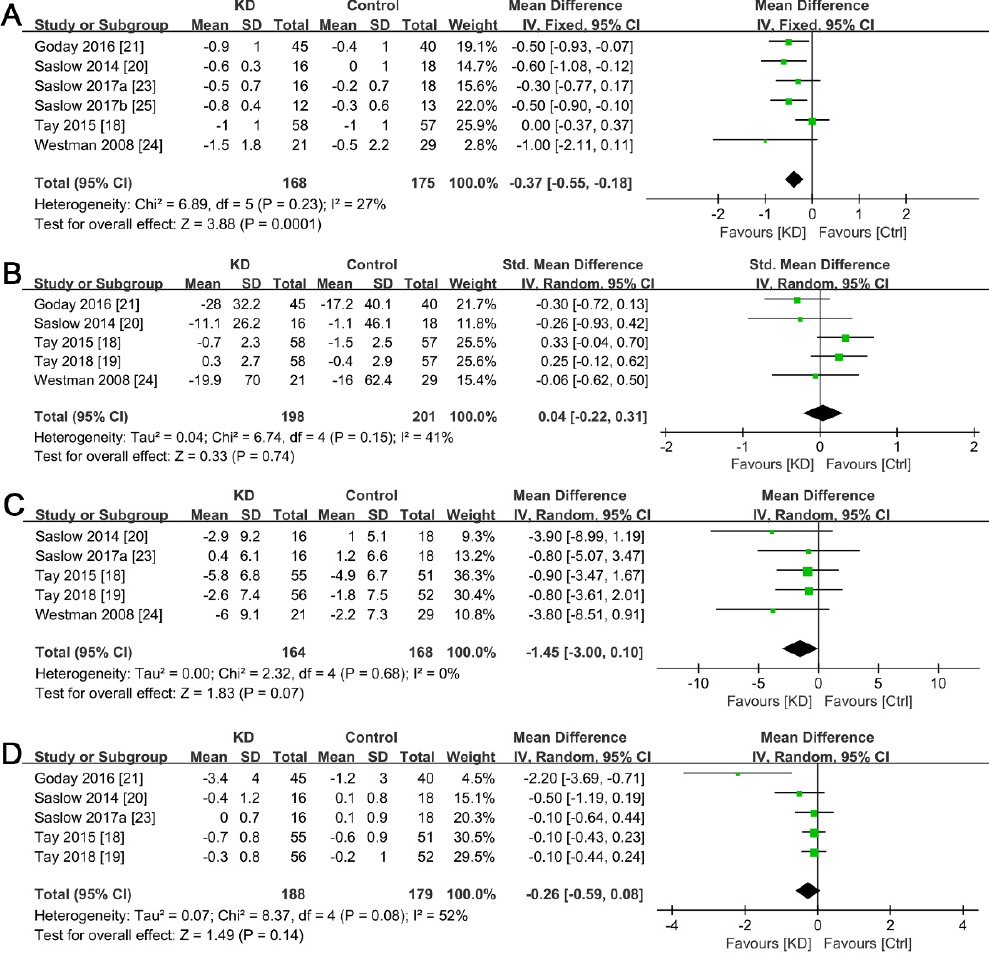
Figure 4. Forest plots for the effects of post-intervention versus baseline on glycemic control in overweight T2DM patients. ( A ) Changes in HbA1c; ( B ) Changes in fasting glucose; ( C ) Changes in fasting insulin; ( D ) Changes in HOMA-IR. The green squares represent individual effect sizes, and the black diamonds represent pooling effect sizes.